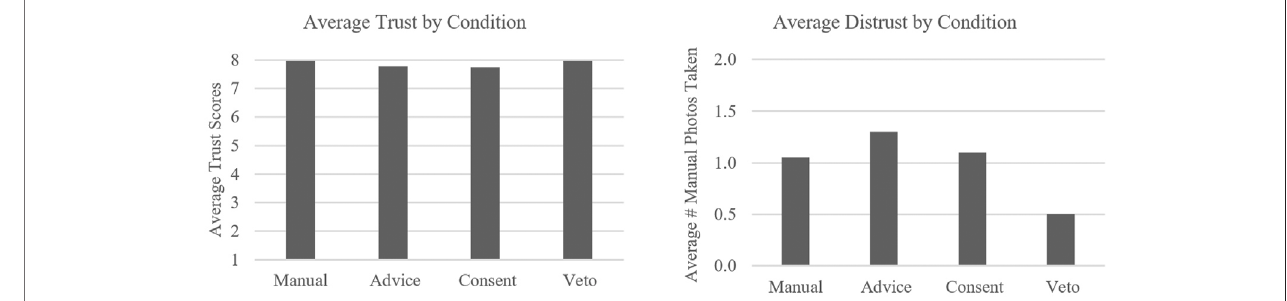
FIGURE 4 | Average trust and distrust ratings by condition.